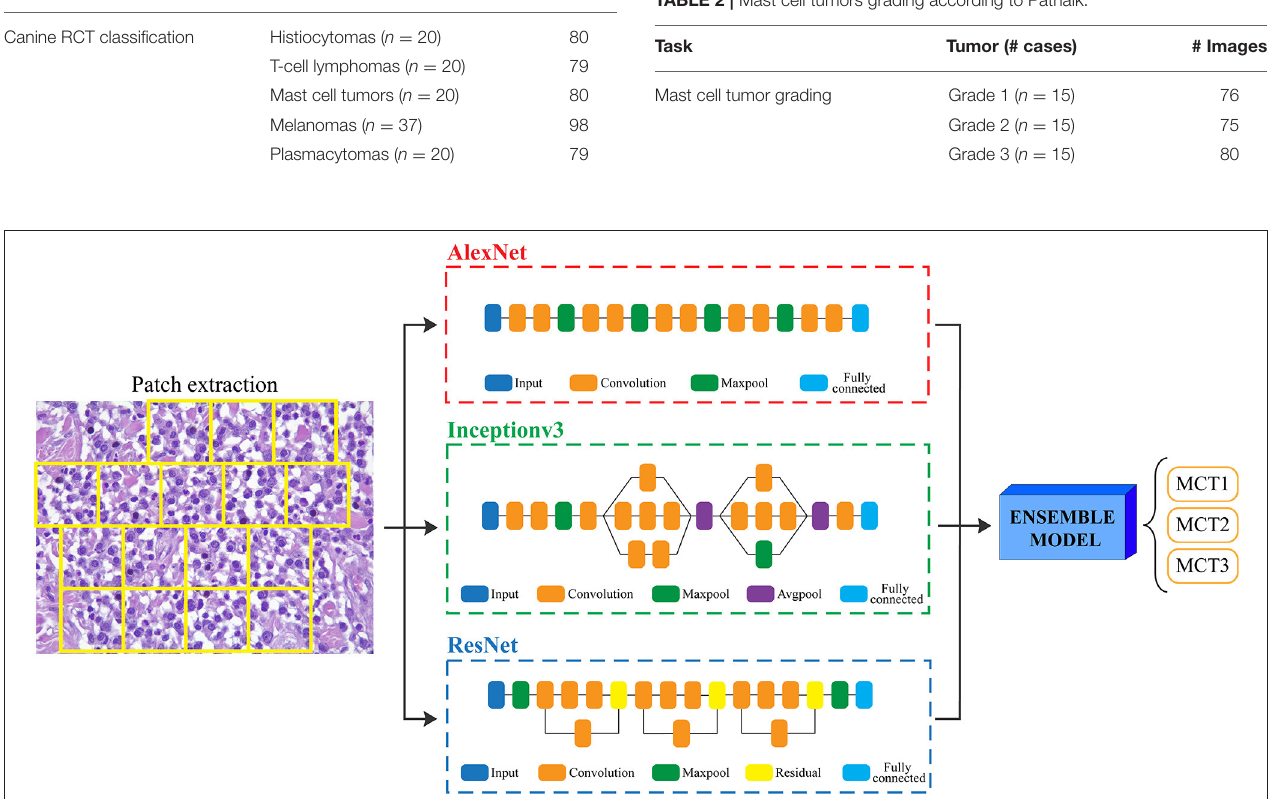
FIGURE 2 | Flowchart for mast cell tumors grading. After patch extraction, three different CNNs (AlexNet, Inceptionv3, and ResNet) are employed for classification. Then, an ensemble model averages all the CNNs predictions to obtain the final grading of the image. MCT1: grade 1, MCT2: grade 2, MCT3: grade 3.